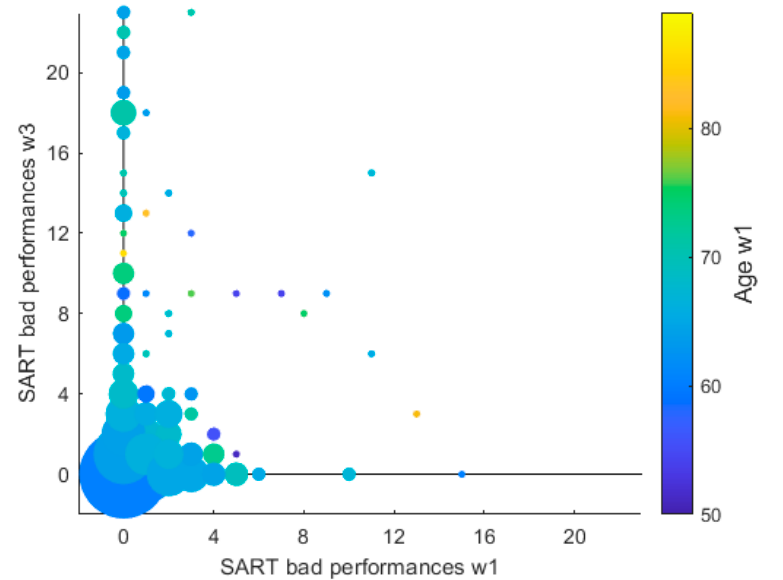
Figure 5. Evolution of the variable bad performances between wave 1 (along the x -axis) and wave 3 (along the y -axis). The colour of the spots represents the age at wave 1. The size of the spots indicates the density distribution of the variables.